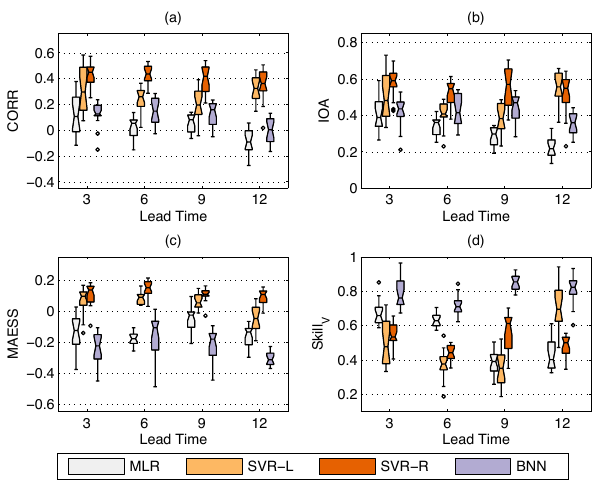
Fig. 4. Same as Fig. 2, except over the Prairies (region R3).